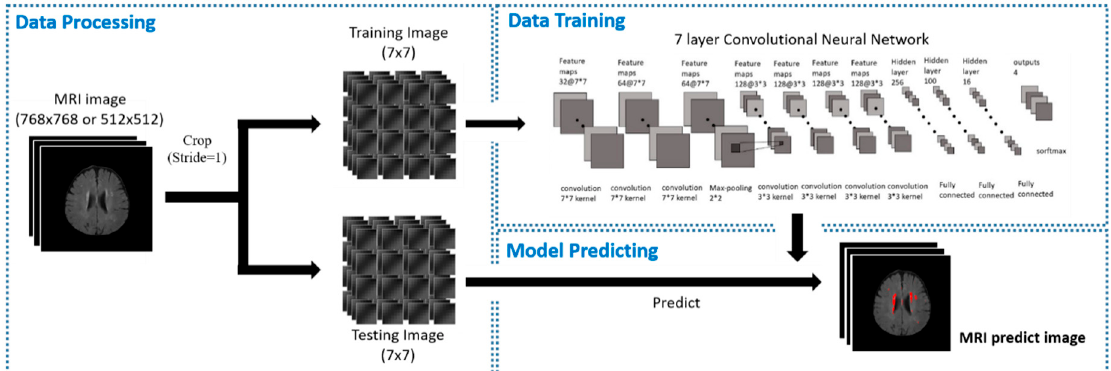
Figure 2. ( Left ) is an image of the area of the cerebral small vessel lesion by the physician, and ( right ) the image marked by the physician as a ground-truth.